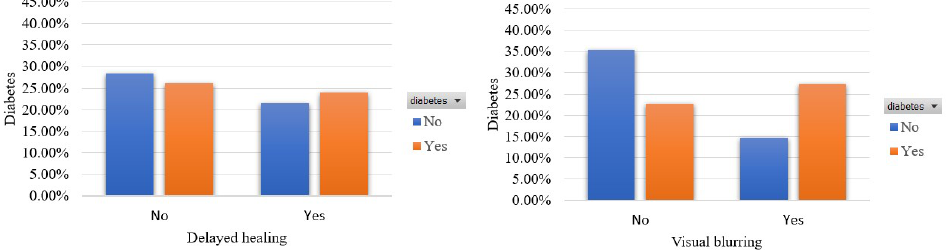
Figure 8. Participants’ distribution in terms of delayed healing and visual blurring in the bal- anced